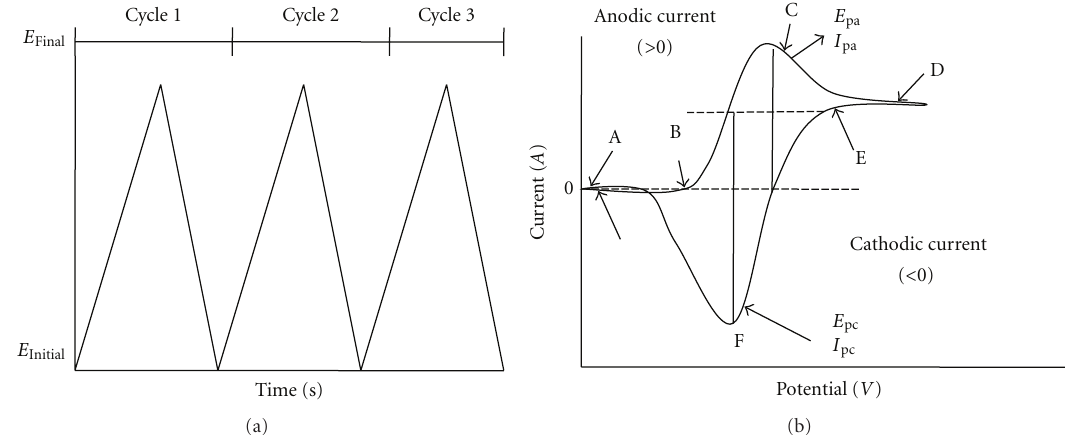
Figure 8: (a) A cyclic voltammetry potential wave form with switching potentials and (b) the expected response of a reversible redox couple during a single potential